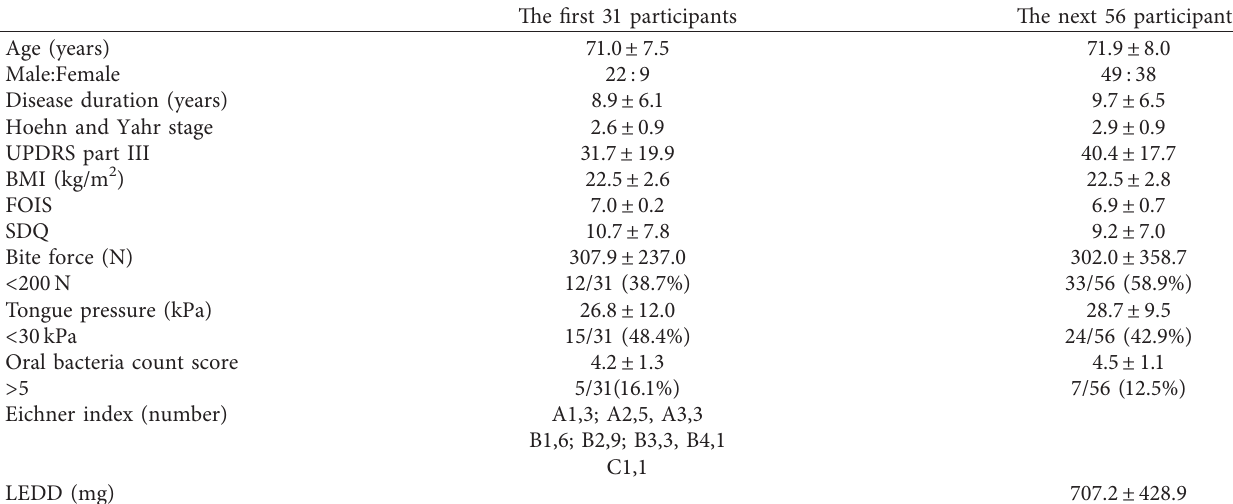
Table 1: Characteristics of the first 31 and next 56 participants, and mean values and